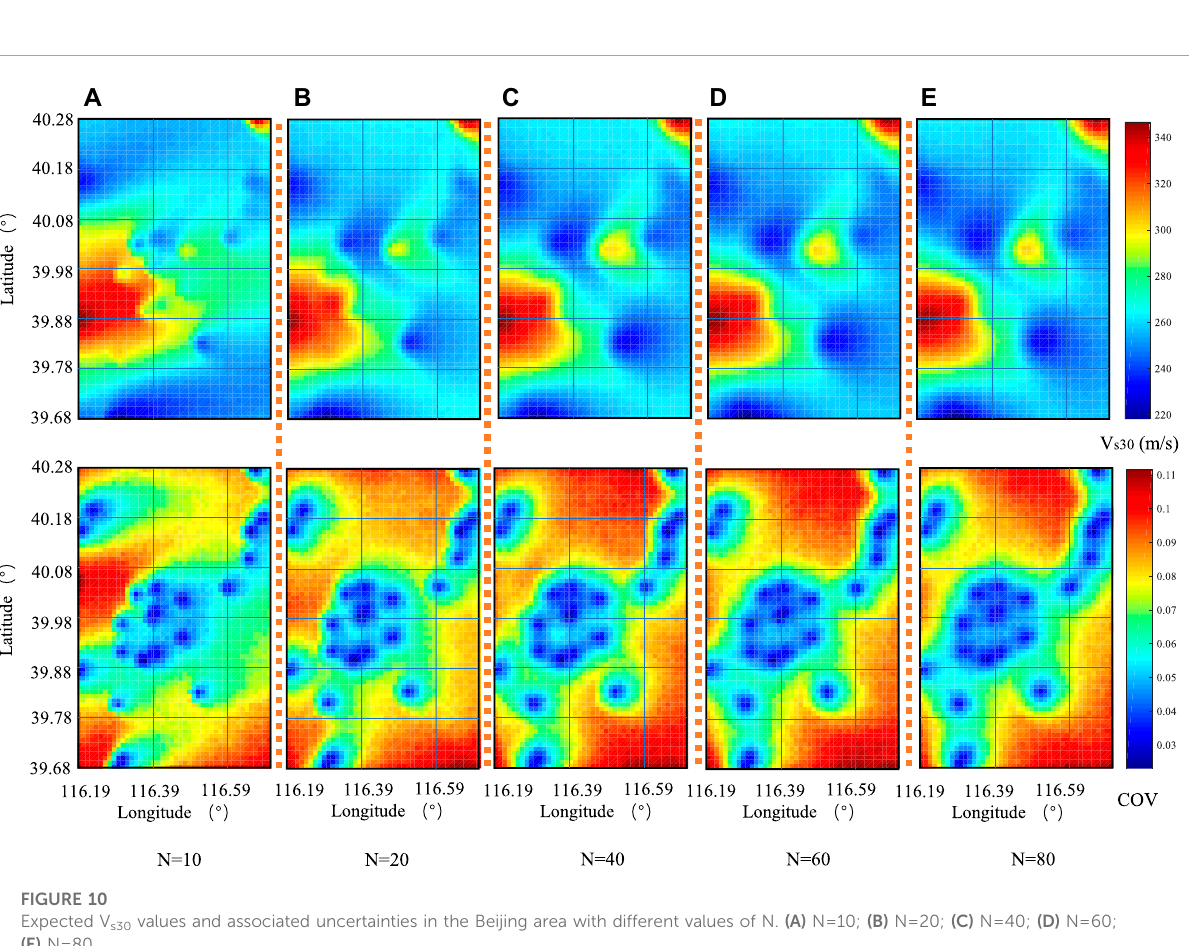
Expected V s30 values and associated uncertainties in the Beijing area with different values of N. (A) N=10; (B) N=20; (C) N=40; (D) N=60; (E)